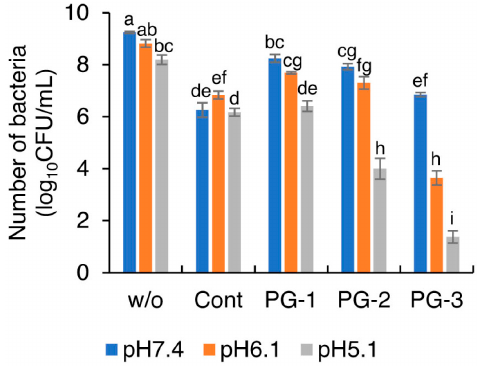
Figure 6. Number of viable S. mutans after 24 h incubation at pH 5.1, 6.1, and 7.4 with four glass particles. Bars represent the standard deviations of six replicates. a – i: letters indicate significant differences ( p < 0.05, ANOVA, Tukey’s HSD test). w/o, without any powders.